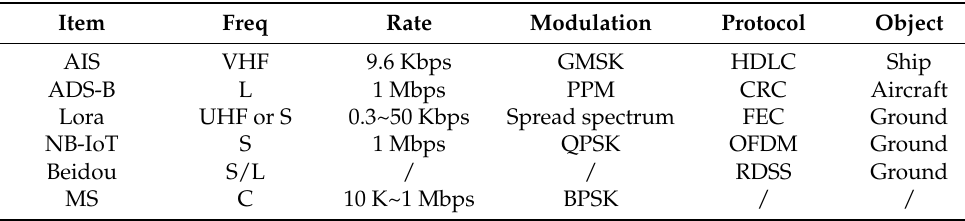
Table 4. Various DCS